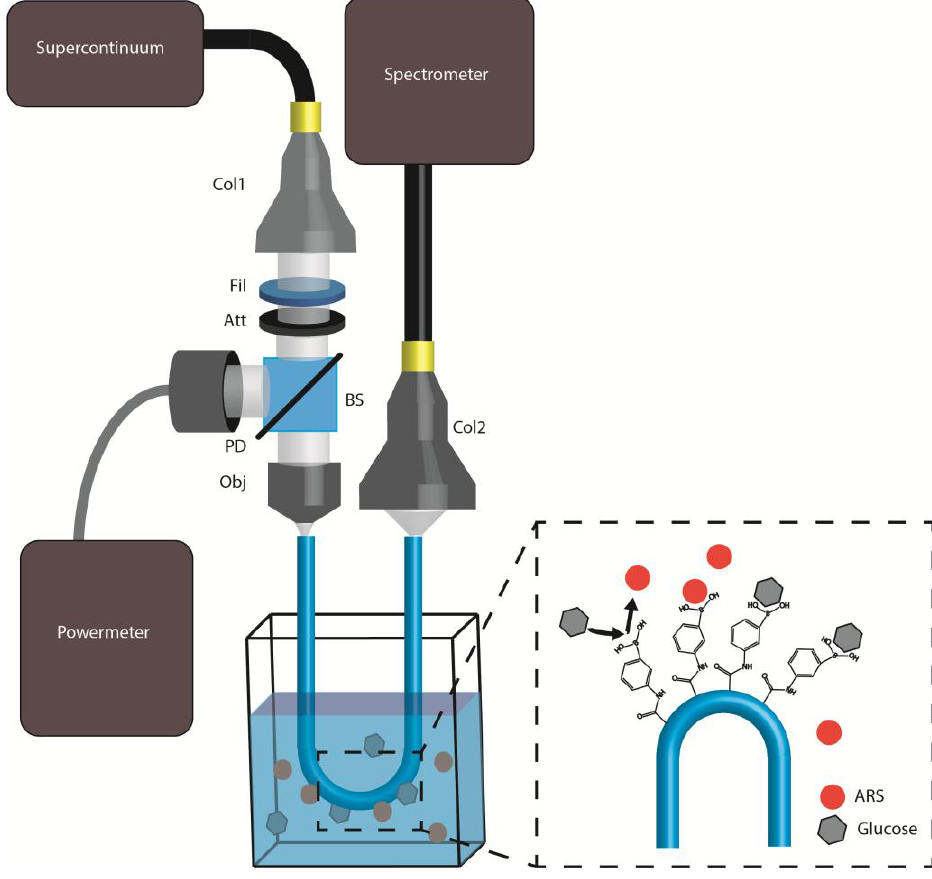
Figure 6. Experimental setup employed to carry out the measurements. Legend: Col1/Col2: collimators, Fil: band-pass filter (390–750 nm), Att: optical attenuator of optical density 3, BS: beam-splitter, Obj: objective, and PD: photo detector; next to the cuvette a chemical illustration of the disaggregation of the ARS is also shown.